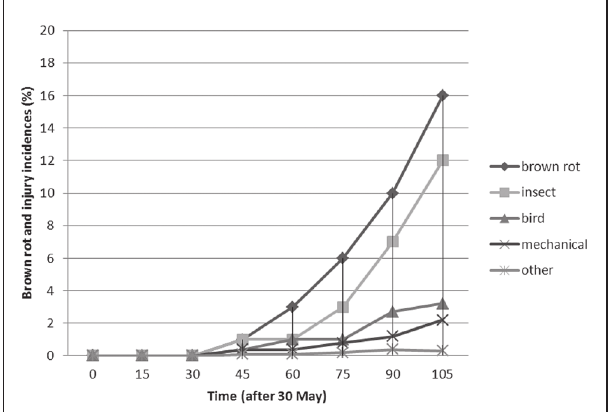
Figure 2. Incidence of brown rot and injry types from 30 May until September (Eperjeske, Hungary,